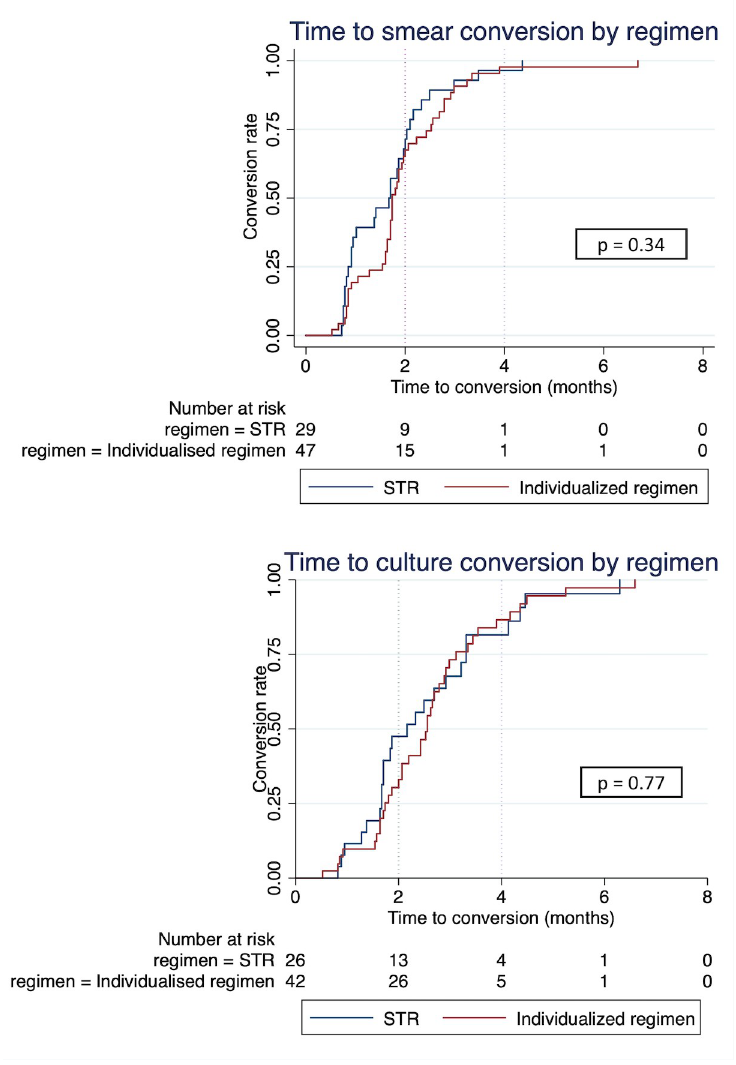
Fig 2. Kaplan-Meier estimates of time to smear and culture conversion. Smear and culture conversion are considered as at least one negative result following positive baseline results and not followed by smear or culture reversion during